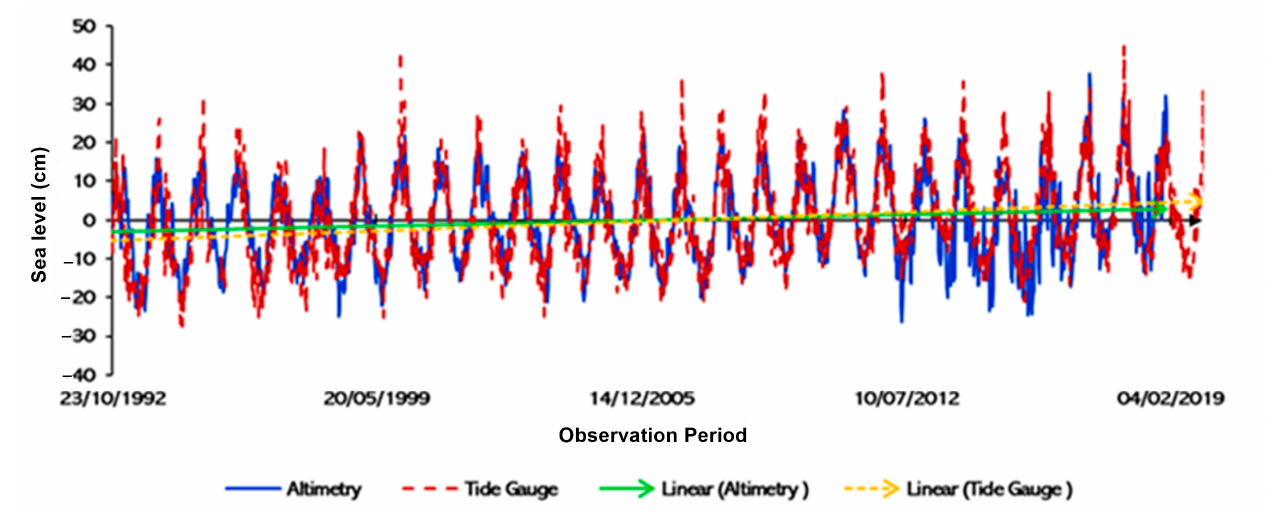
Figure 2. Sea level variations derived from altimetry vs. tide gauge measurement (RMSD = 0.788 cm).